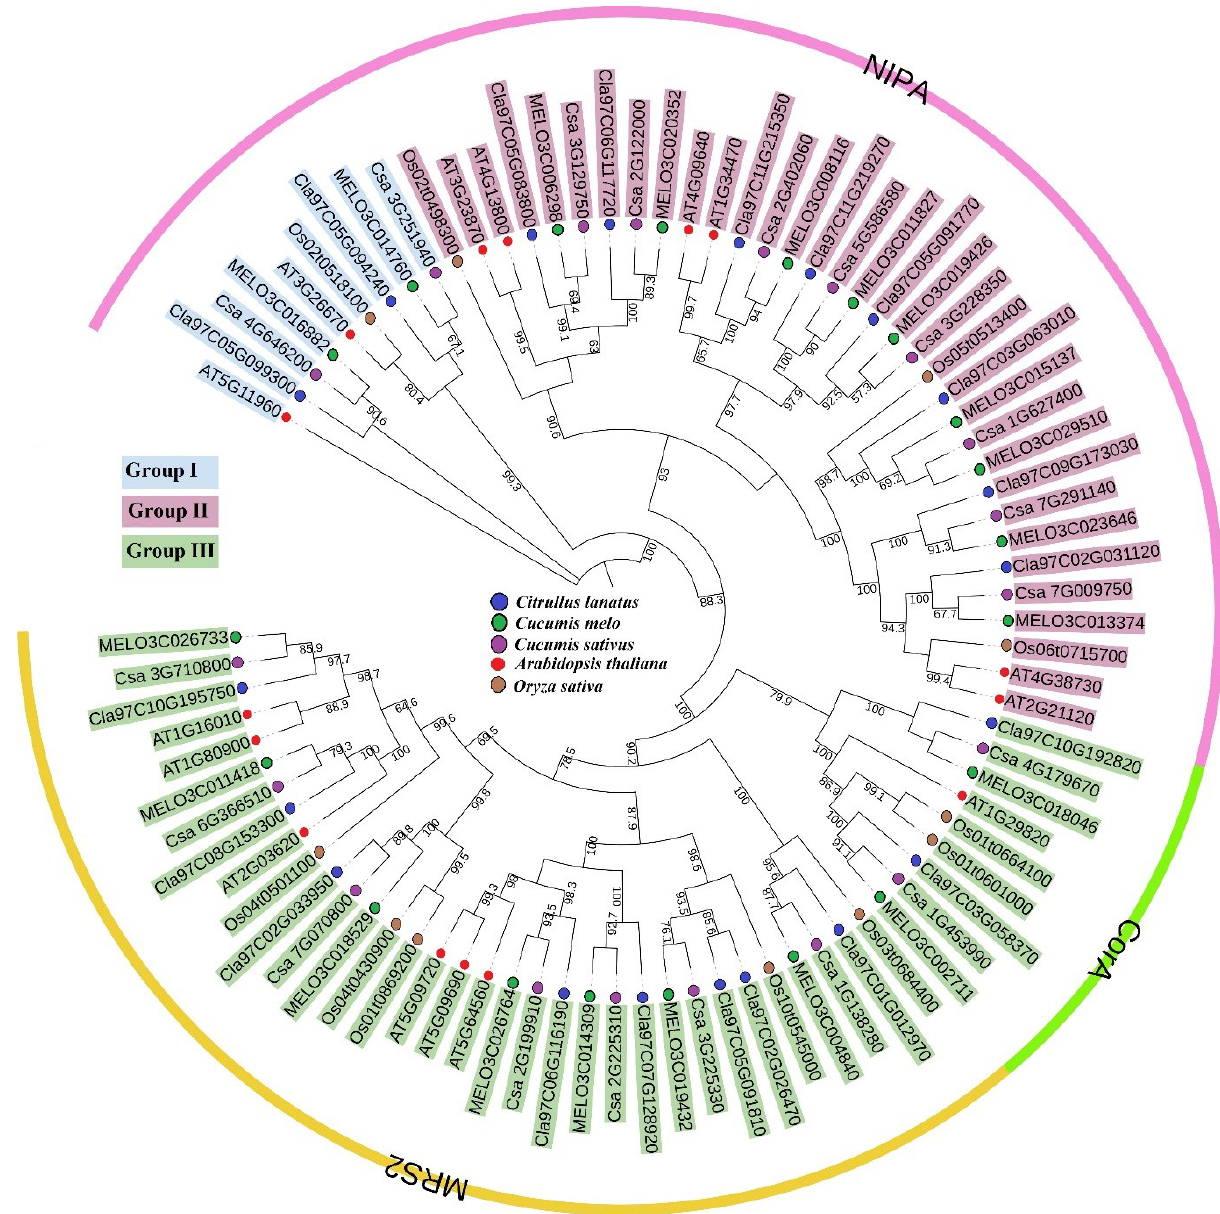
Figure 1. Phylogenetic analysis of MGT families in five different species, Arabidopsis thaliana , Oryza sativa , Citrullus lanatus , Cucumis sativus , and Cucumis melo . The phylogenetic tree was constructed by the maximum likelihood method. Different colored backgrounds indicate different groups.